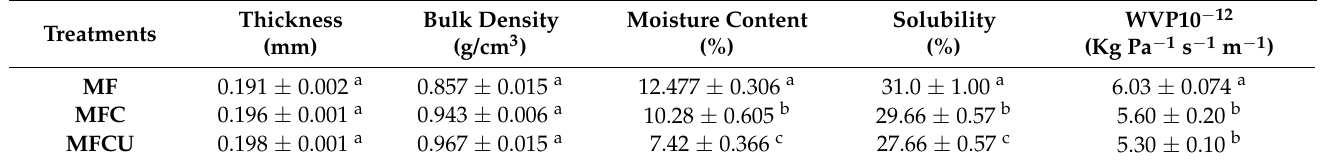
Table 1. Physical properties of mung bean flour-based films processed under different conditions.